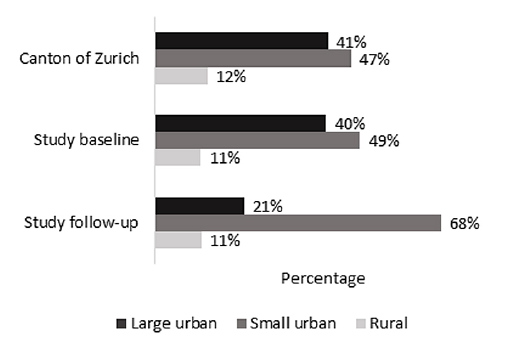
Figure 3: Proportion of schools by degree of urbanisation in the canton of Zurich and in the LuftiBus in the School (LUIS) study at baseline and follow-up. Definition of urbanisation degree: cities or large urban area: at least 50% lives in high-density clusters. Towns and suburbs or small urban area: less than 50% of the population living in rural grid cells and less than 50% living in a high-density cluster. Rural area: more than 50% of the population living in rural grid